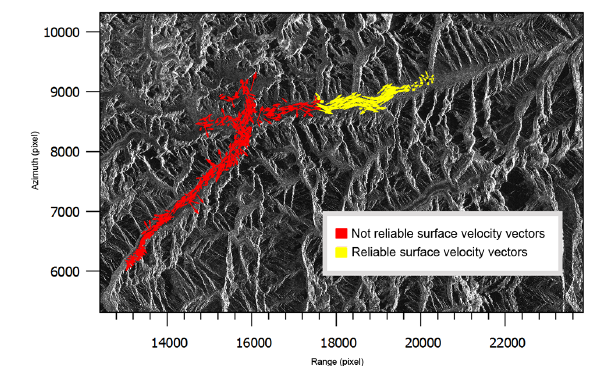
Figure 6: Experimental results of Biafo Glacier during the